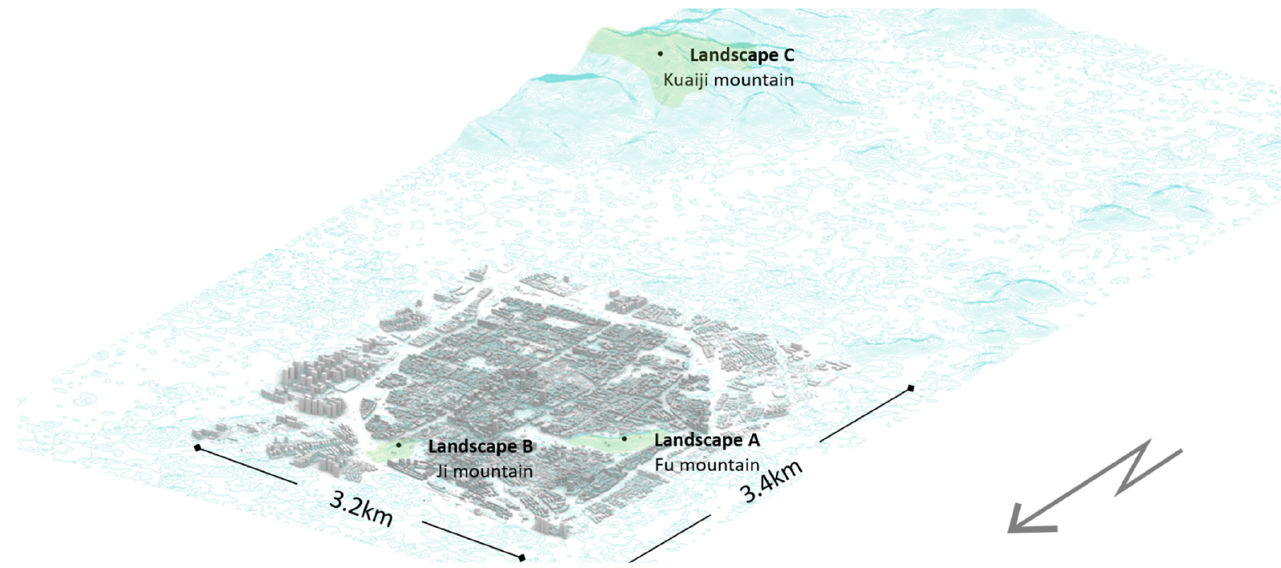
Figure 2. Presentation of spatial data of the test site.